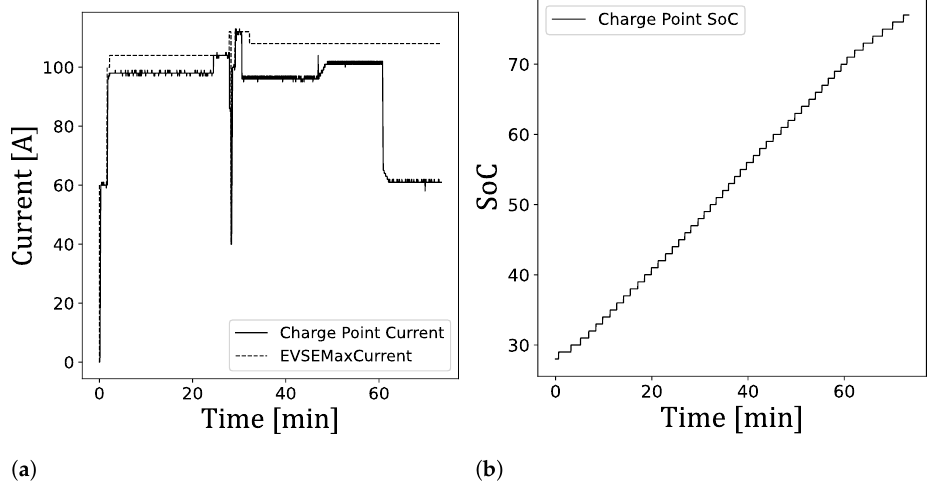
Figure 15. Measured Bulk Charging Process of a Hyundai KONA (2019). ( a ) Charge Current and Maximum Current Limit and ( b ) State of